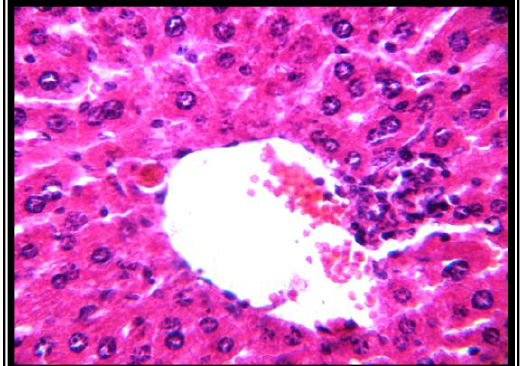
Fig. 6 (H&E 400 X): Testis histological sections of a mouse treated orally with MSG at a dose of 3 g per Kg of body weight showed thickening of the basement membranes of the semineferons tubules with vaculation of